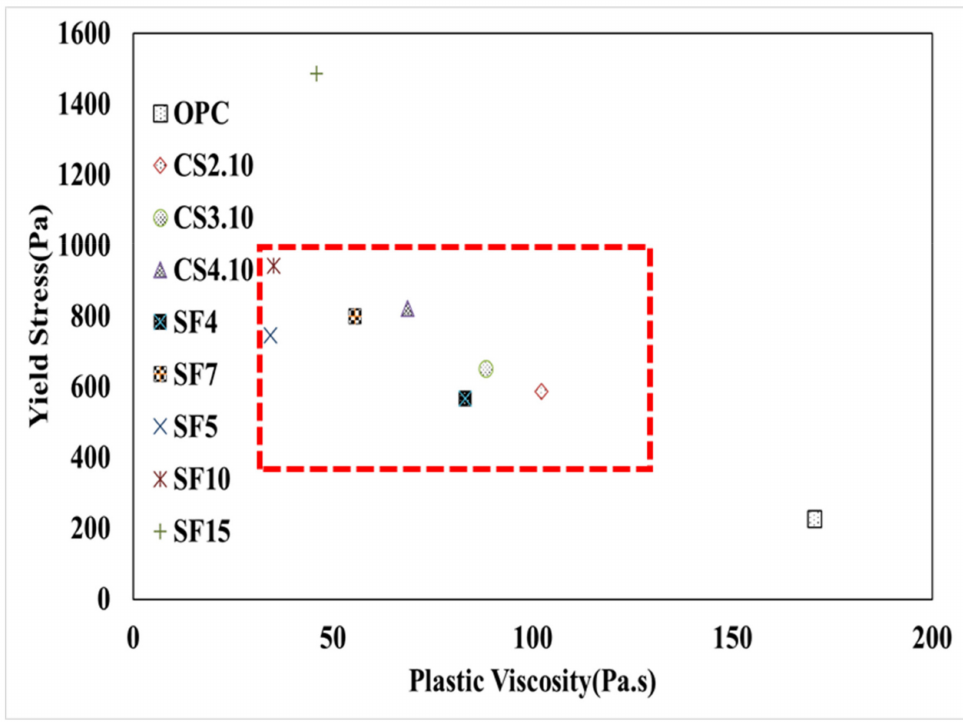
Figure 22. Pumpability identification by the Bingham model result of all mixing ratios (own results and Jeon’s indicated with SF5, SF10, and